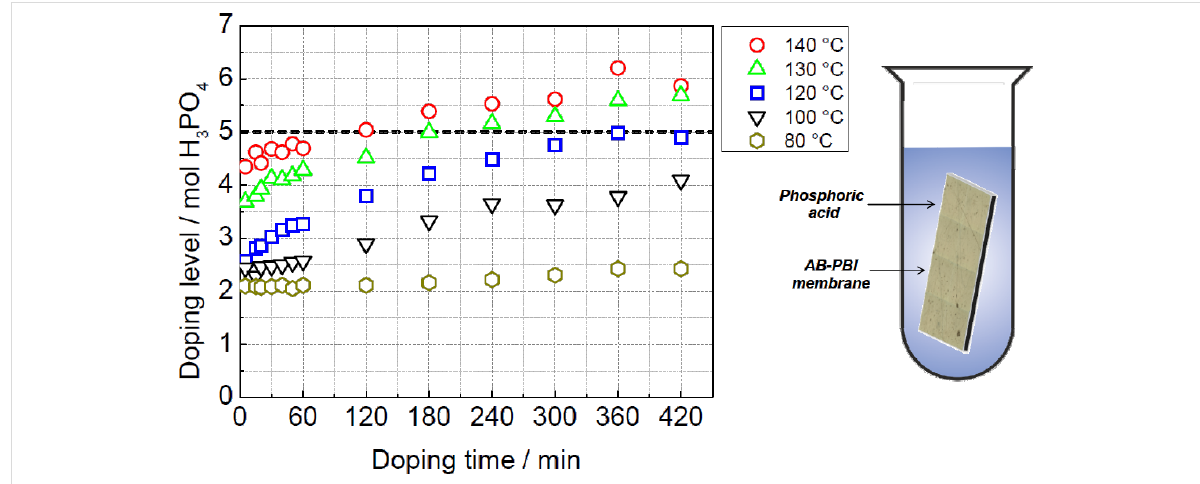
Figure 4: Doping process of an AB-PBI membrane in hot phosphoric acid at various temperatures. The weight increase of AB-PBI membranes corre- lates with the phosphoric acid solution temperature and immersion time (left). Schematic drawing of an AB-PBI membrane immersed in hot acid (right). Reprinted with permission from [34]. Copyright 2014